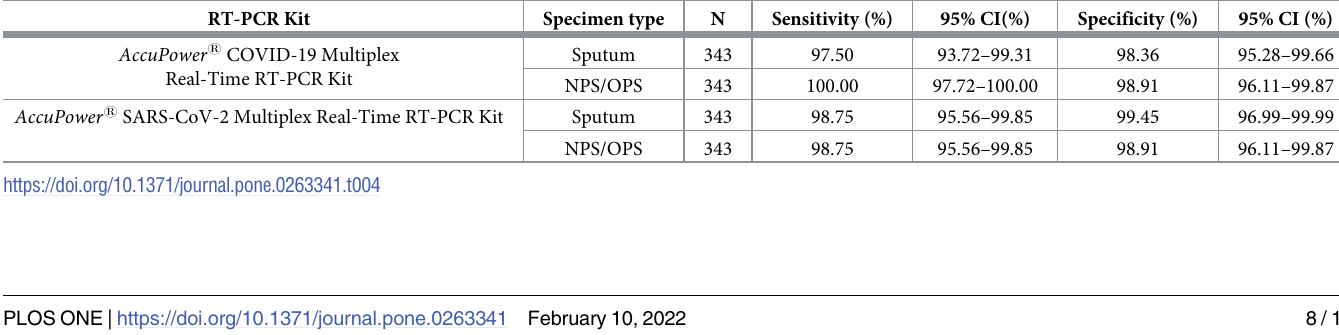
The clinical performance of the SCVM was evaluated by comparing it to the confirmation